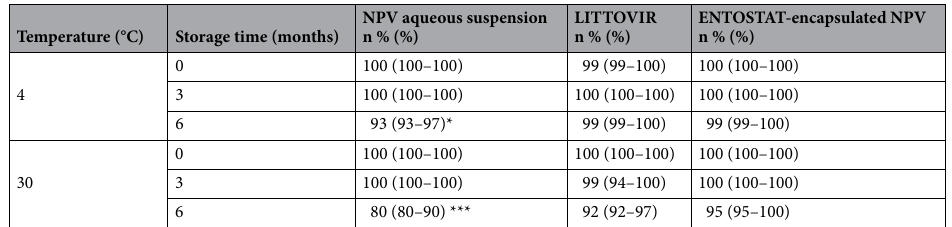
Table 2. Virus-induced mortality of S. littoralis larvae inoculated with one of three SpliNPV formulations stored for 0, 3 or 6 months at 4 °C or 30 °C. Values are means (range), n = 5 replicate bioassays. Comparison with LITTOVIR commercial standard at 4 °C (LM: *P < 0.05, ***P <